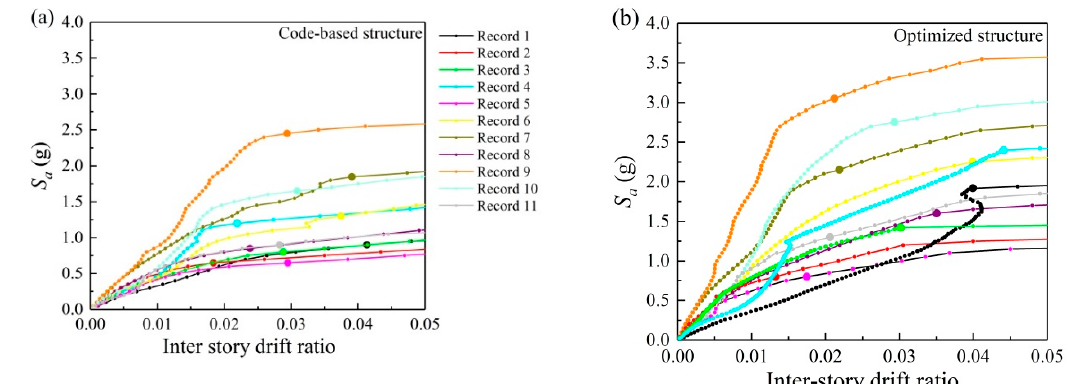
Figure 9. IDA curves comparison of CSDBC-designed structure and optimized structure: ( a ) IDA curves for code-based structure, ( b ) IDA curves for optimized structure.